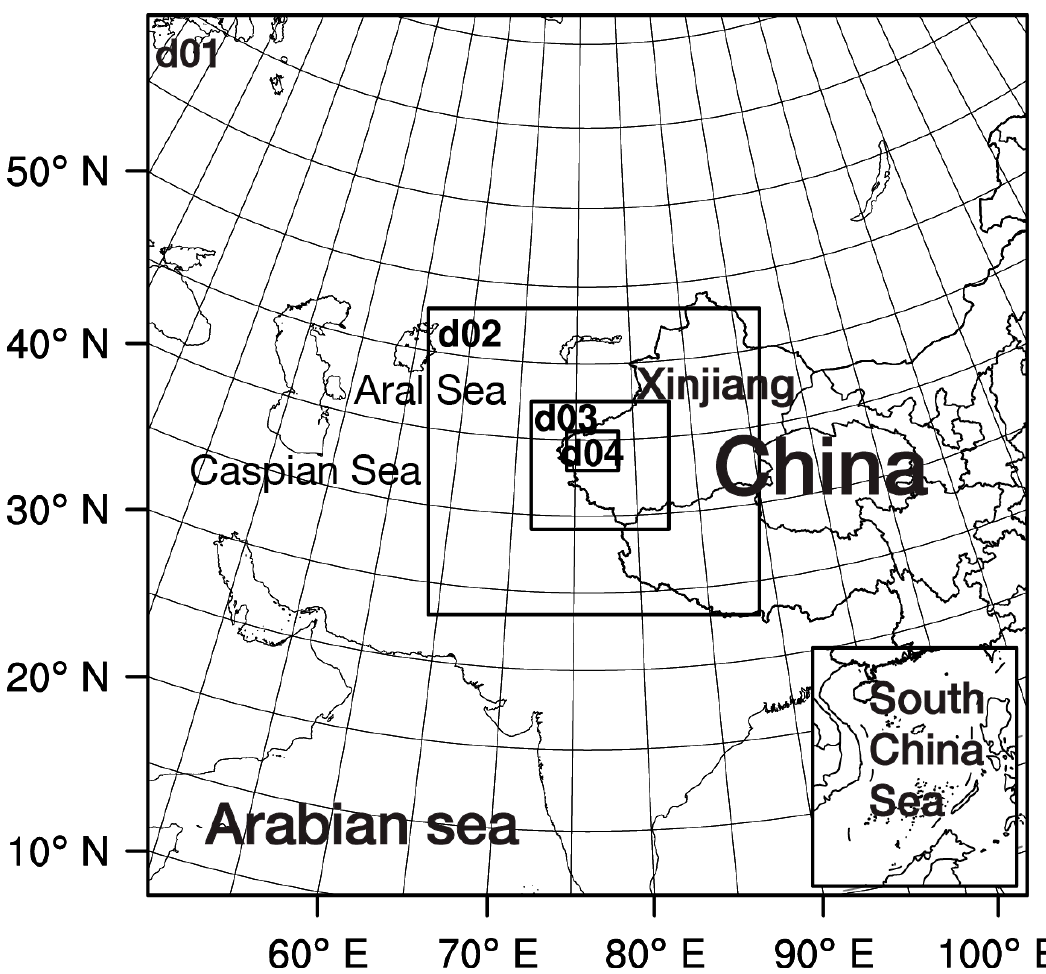
Figure 5. Geographic locations of the WRF model domains. The innermost domain (d04) covers the